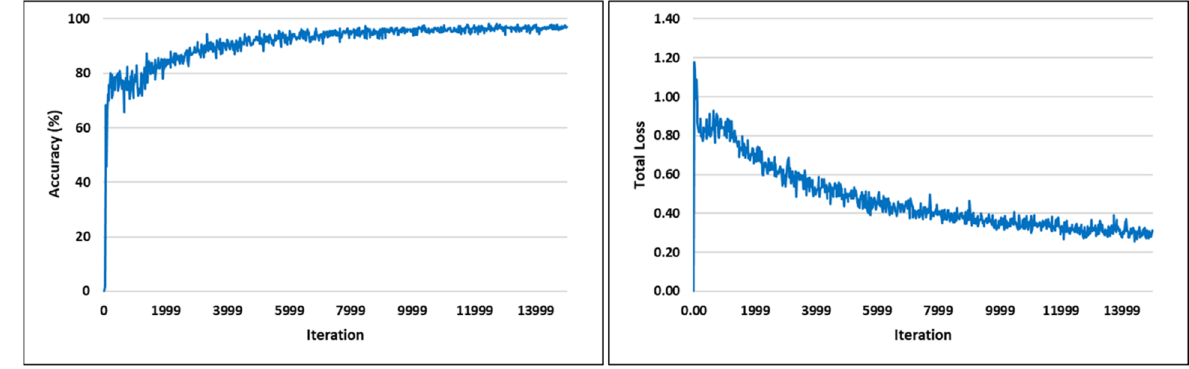
Figure 12. Visual analysis of Faster R-CNN evaluation indicators during training.